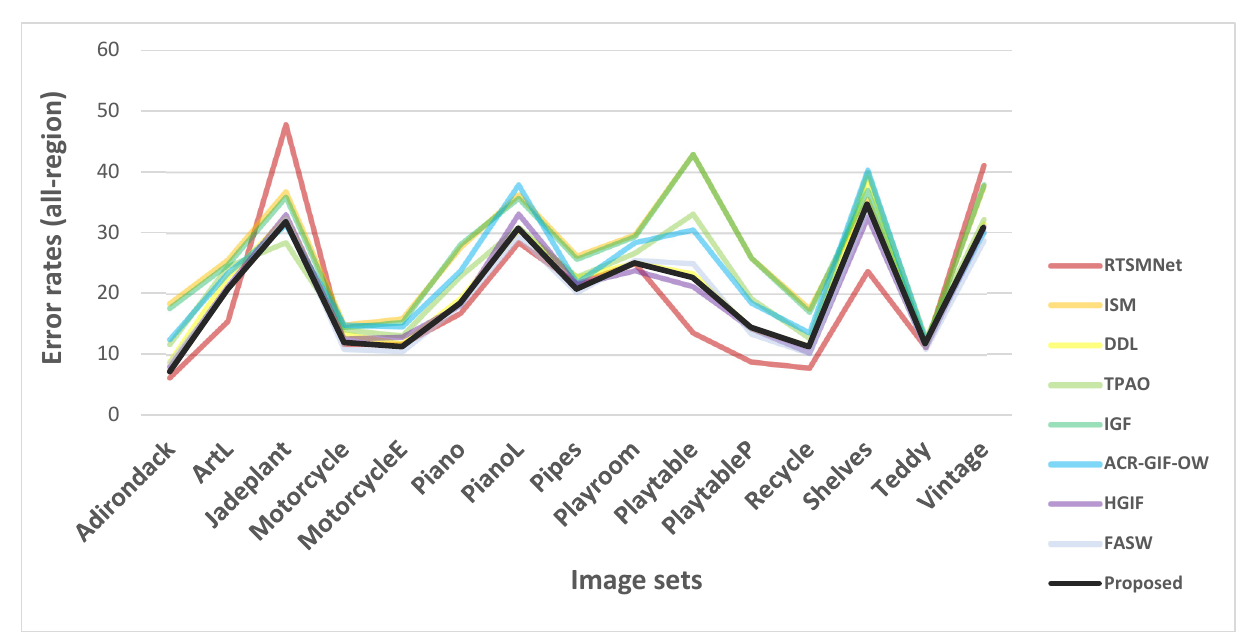
Figure 7. Comparison of the error rates in the all-region. This diagram is a graphical representation of Table 3.